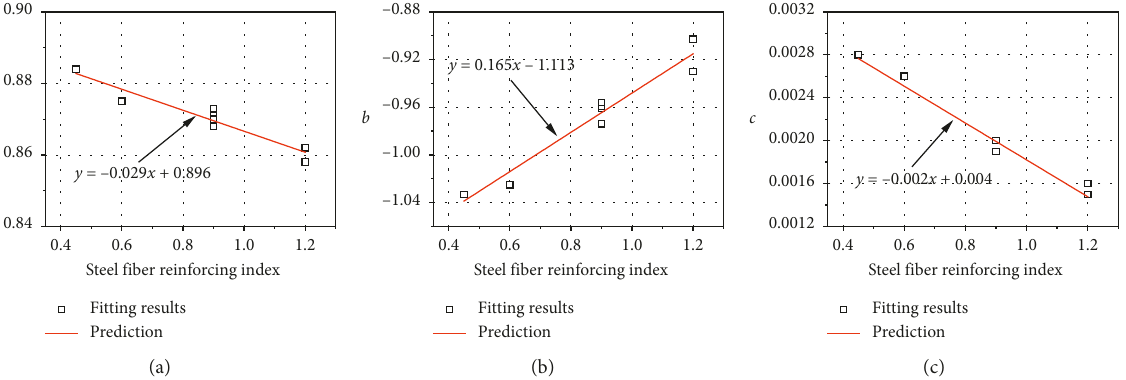
Figure 15: Fitting results of parameters of tensile damage evolution laws: (a) parameter a ; (b) parameter b ; (c) parameter c .